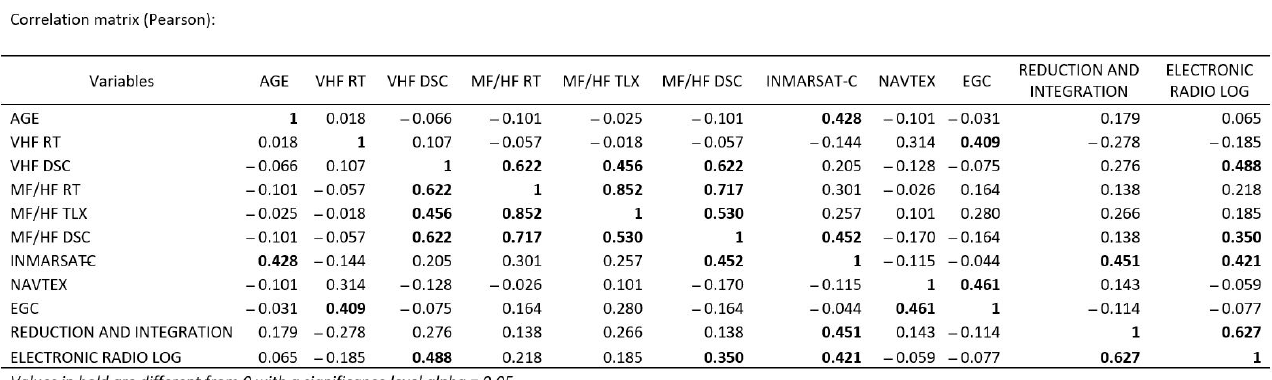
Figure 13. Pearson correlation matrix of the respondents’ answers.